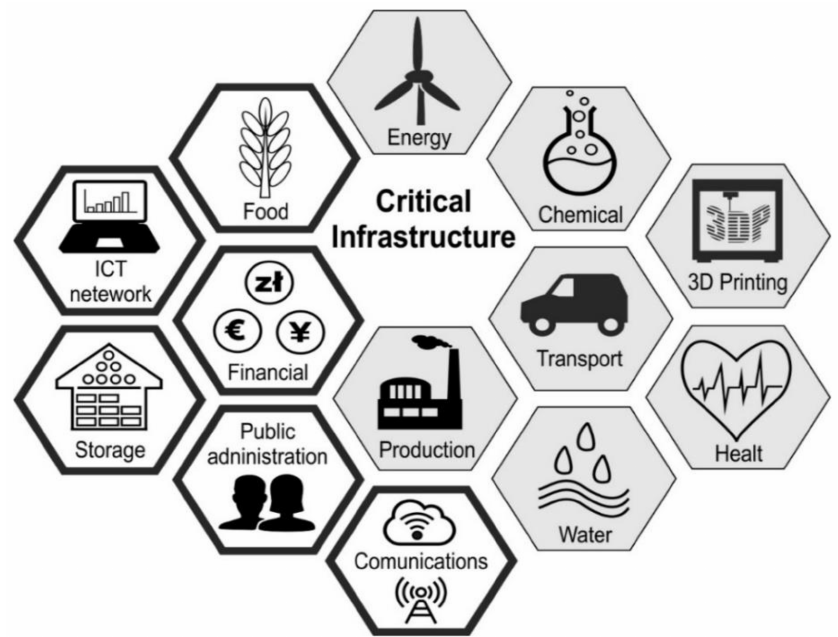
Figure 1. Critical infrastructure diagram incorporating 3D